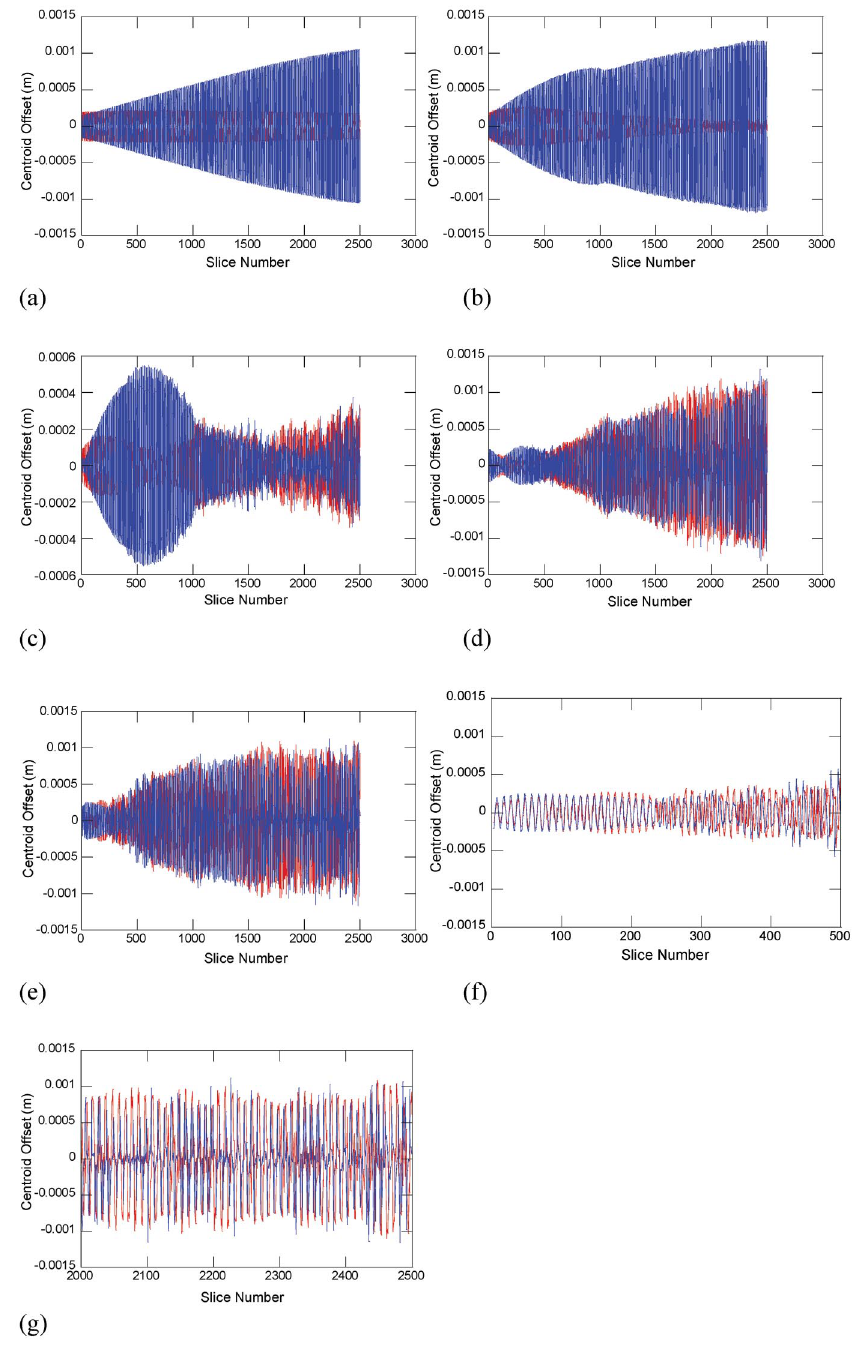
FIG. 19. (Color) Electron-beam centroid evolution for 20-MeV, 3-mm, periodic-focusing beam case at different axial positions. Each slice is 0.4 nsec long. The red line is for the horizontal offset and the blue line is for the vertical offset. (a) z (cid:4) 1 m , (b) z (cid:4) 2 m , (c) z (cid:4) 3 m , (d) z (cid:4) 4 m , (e) z (cid:4) 5 m , (f) blowup of first 500 slices at z (cid:4) 5 m , and (g) blowup of last 500 slices at z (cid:4) 5 m